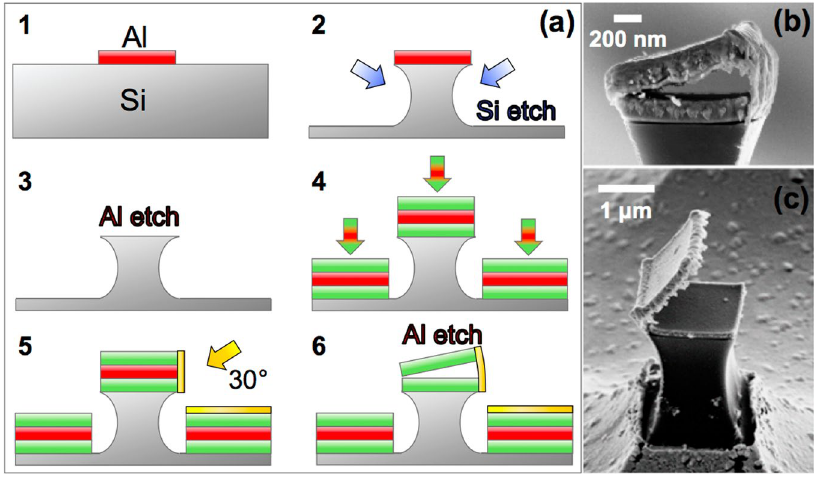
Figure 2. ( a ) Flowchart of the fabrication process of the tweezers. (1) The Al metal mask is patterned and deposited on the Si substrate. (2) Pillars are obtained after performing isotropic RIE. (3) The Al mask is etched away from the pillars, so that (4) the stack of metal layers that will form the base of the jaws can be deposited. (5) Then, the Au nanohinge is deposited with a 30° tilted angle, before (6) finally removing the sacrificial layer in the middle of the stack. ( b ) SEM image of a SM/SM tweezers. Both jaws are made of permalloy. ( c ) SEM image of opened SM/NM tweezers. The soft and nonmagnetic jaws are made of permalloy and chromium,